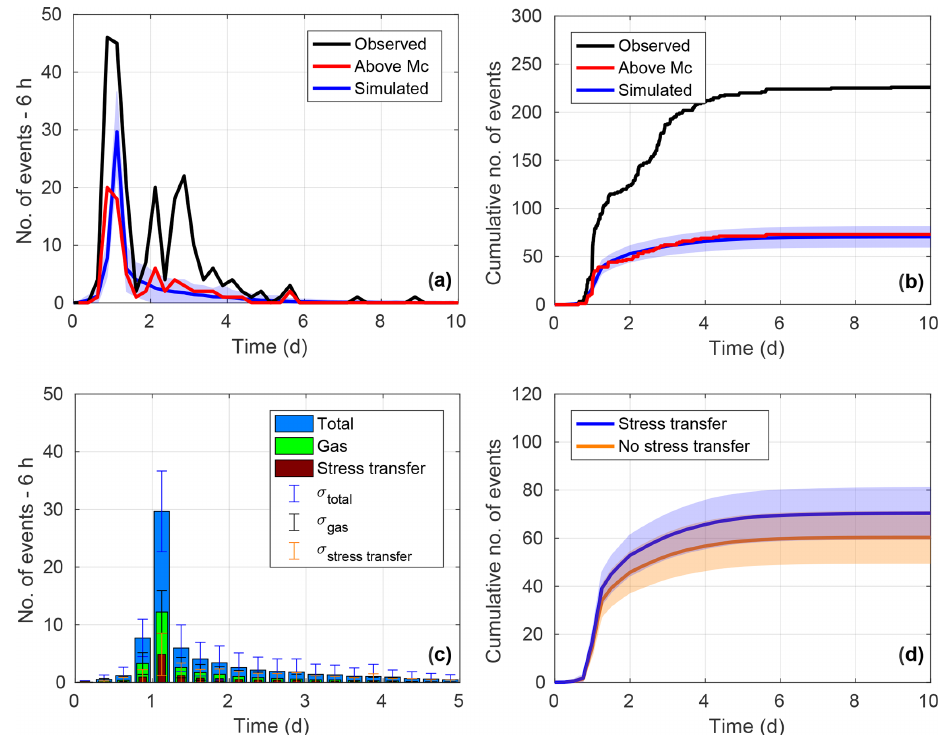
Figure 11. Statistical analysis of the main sequence simulation. (a) Number of events for every 6h compared to the entire relocated catalog and events above M c . (b) Cumulative number of events with time compared to the entire relocated catalog and events above M c . (c) Number of events for every 6h induced in total, by the gas and by static stress transfer. (d) Comparison of simulated cumulative number of events with and without stress transfer. The shaded area in (a) , (b) , and (d) and the error bars in (c) indicate 1 standard deviation over a total of 1000 realizations. Zero-time corresponds to the breach of the seal to initiate the gas